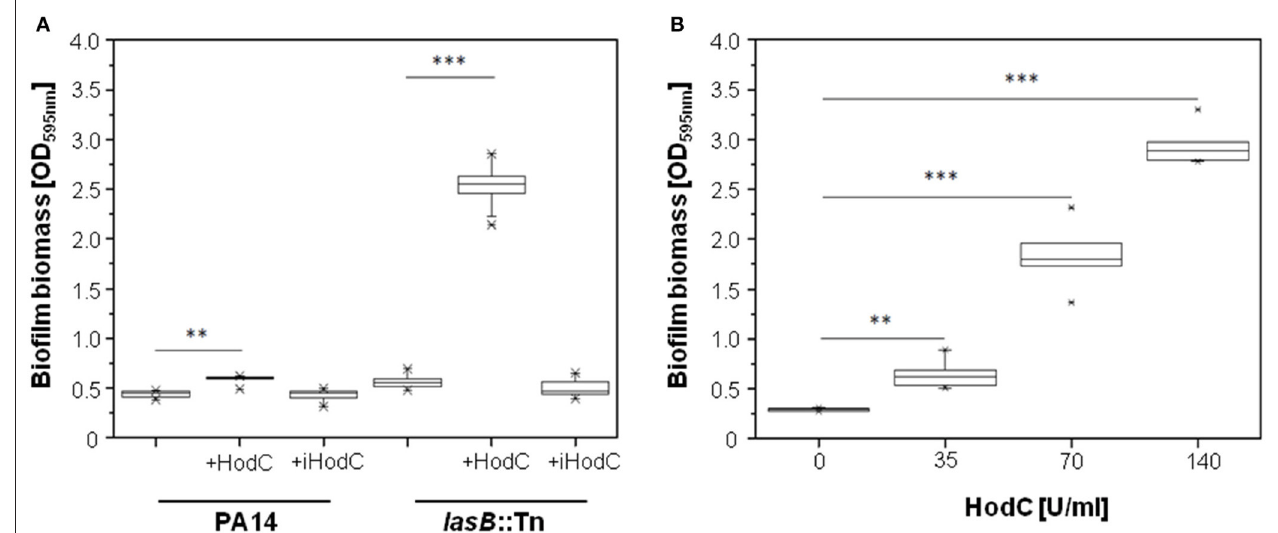
FIGURE 2 | Effect of HodC on biofilm formation of P. aeruginosa . (A) Effect of HodC (70 U/ml) and iHodC (at the same protein concentration) on wild-type P. aeruginosa PA14 and P. aeruginosa PA14 lasB ::Tn. (B) Biofilm formation in response to different concentrations of HodC. (A,B) Overnight cultures (in LB) were diluted (1:100) in LB in 96-well microtiter plates, and supplemented with HodC protein as indicated. After incubation for 24 h at 37 ◦ C, cells were stained with 0.1% (w/v) crystal violet and quantified by measuring OD 595nm . Experiments were done in triplicates with 6 individual repeats per measurement ( n = 18). Statistical analyses were performed with the Mann-Whitney U -test. ** p ≤ 0.01; *** p ≤ 0.001. The highest and lowest outliers are indicated by “X.”